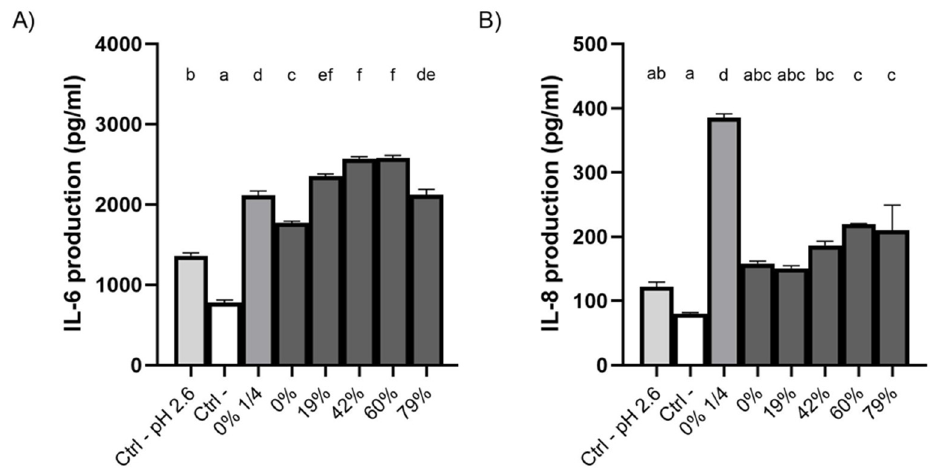
Figure 7. Effect on the production of ( A ) IL-6 and ( B ) IL-8 of a 5-min exposure of GMSM-K oral epithelial cells to raw or deacidified (0, 19, 42, 60, and 79%) cranberry juice. A ¼ dilution of raw CJ was also included. Cells were incubated for 24 h post-exposure, following which the supernatants were collected and the secretion of cytokines was measured. Results are expressed as means ± SD of a triplicate assay. Columns with different letters are significantly different from one another (ANOVA, Bonferroni test, p < 0.01). Ctrl: DMEM+1% FBS.